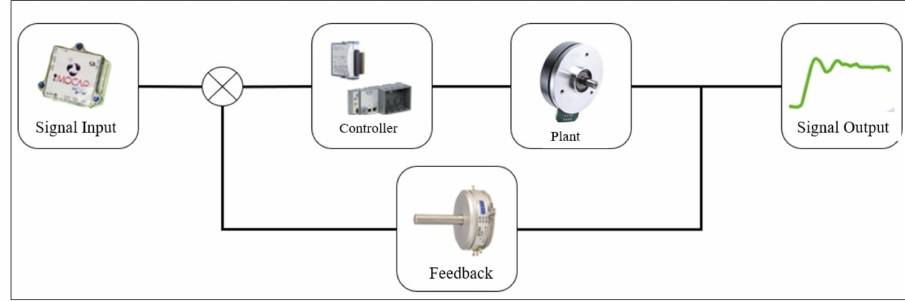
Figure 5. Control diagram of the